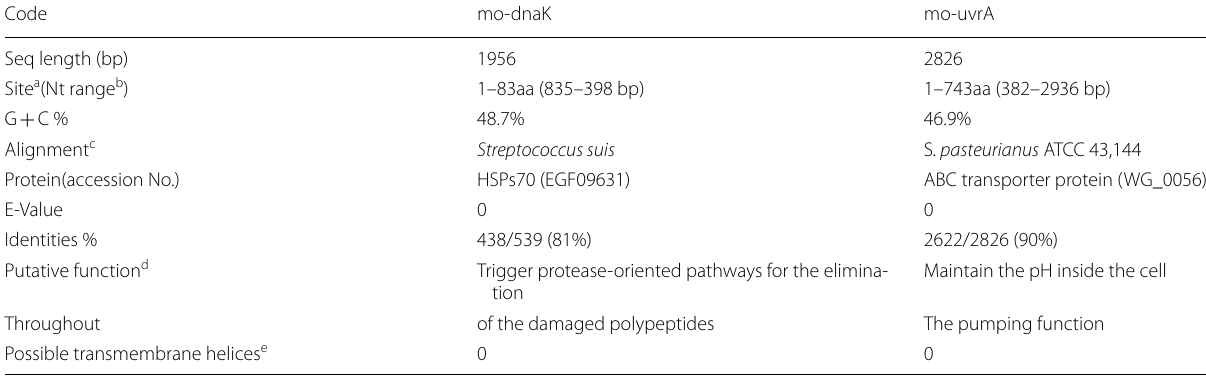
a Protein range (site) of alignment into the known proteins b Nucleotide range (nt range) of the predicted ORF within insert c Most similar protein, currently identified with blast d Most similar protein: putative function e Results from the online server bp base pair, aa amino acids, score bit score of the alignment using BLAST